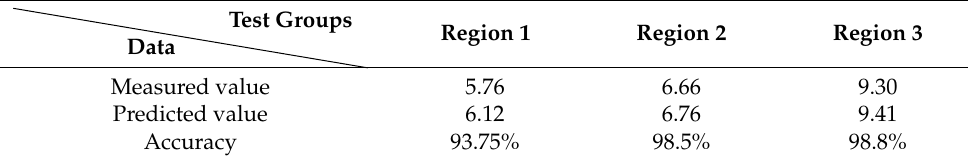
Table 5. Predicted values versus measured values.